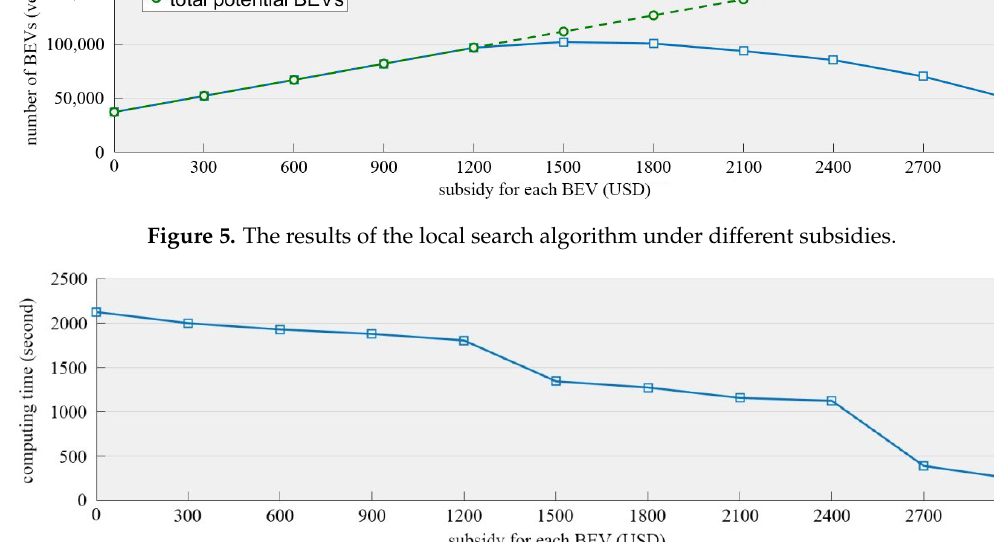
Figure 6. The computing times of the local search algorithm under different subsidies.